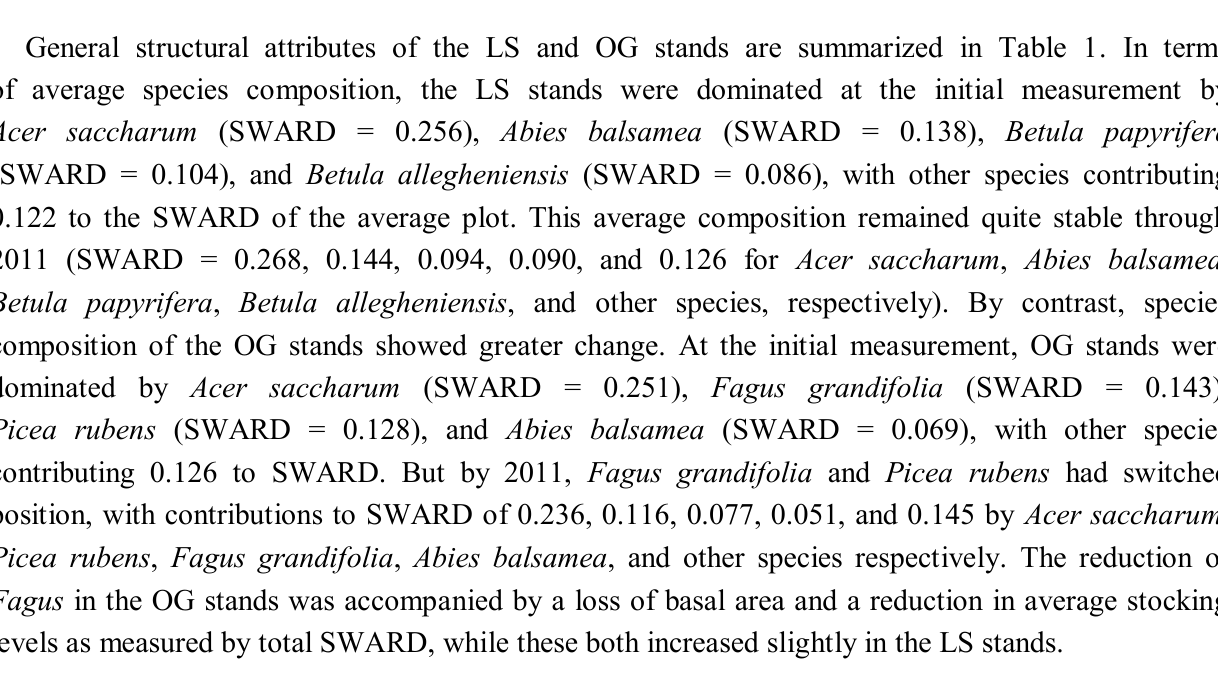
Table 1. General structural attributes of late-successional (LS) and old-growth (OG) stands.